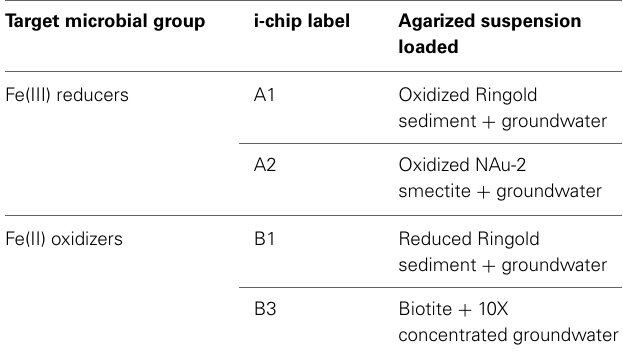
Table 1 | Composition of i-chips used for in situ microbial cultivation. Target microbial